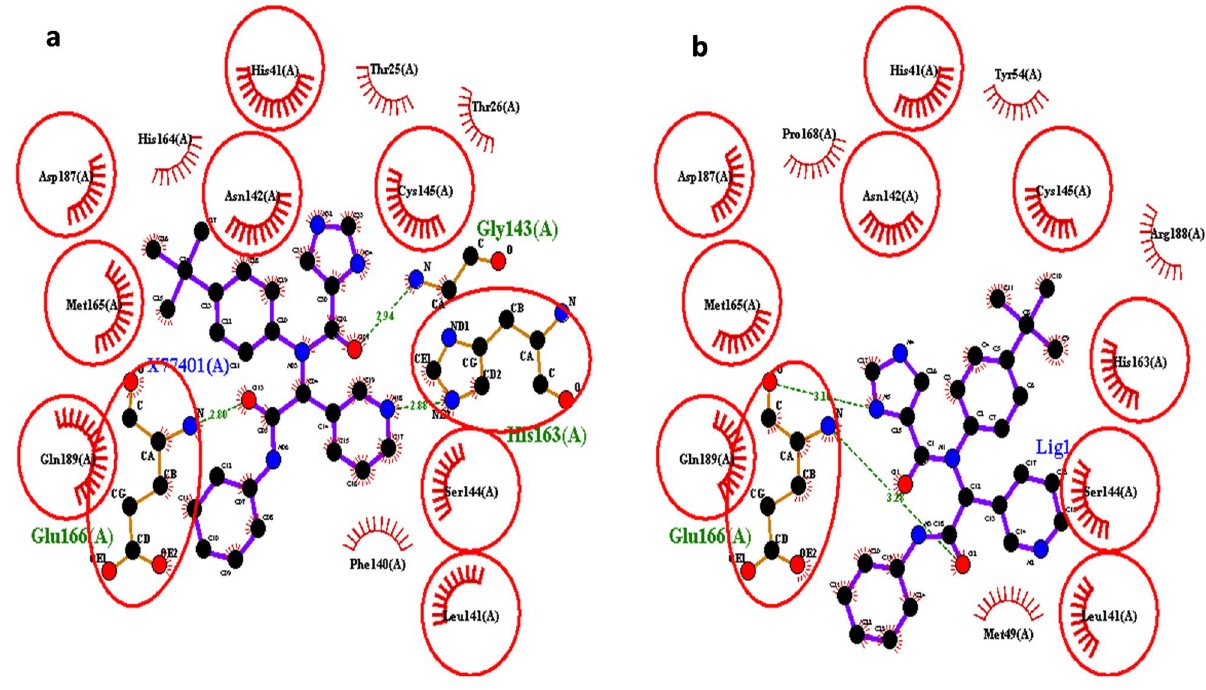
Figure 4. Superimposition of the active site of 3CLpro protein for docking protocol validation: ( a ) 3CLpro protein with attached reference ligand, and ( b ) protein with docked with reference